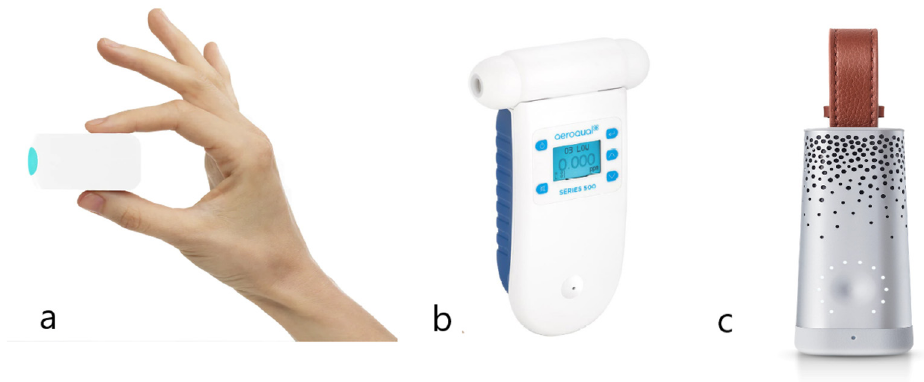
Figure 2. Three commercial products: ( a ) Wynd Air Quality Tracker; ( b ) AEROQUAL’s portable air quality monitor; and ( c ) Plume Labs’ Flow.